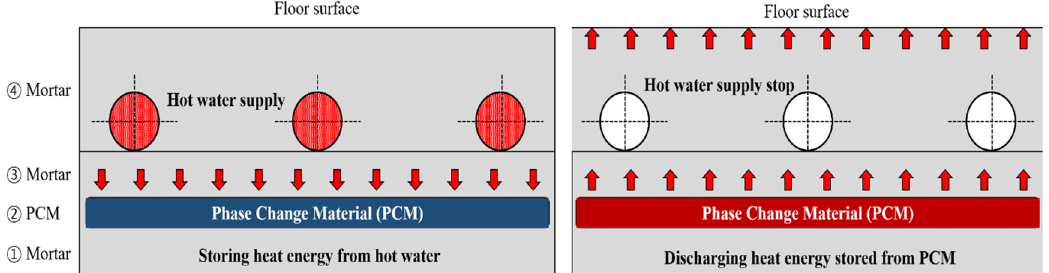
Figure 1. Heat emission from a floor heating system containing a phase change material (PCM).